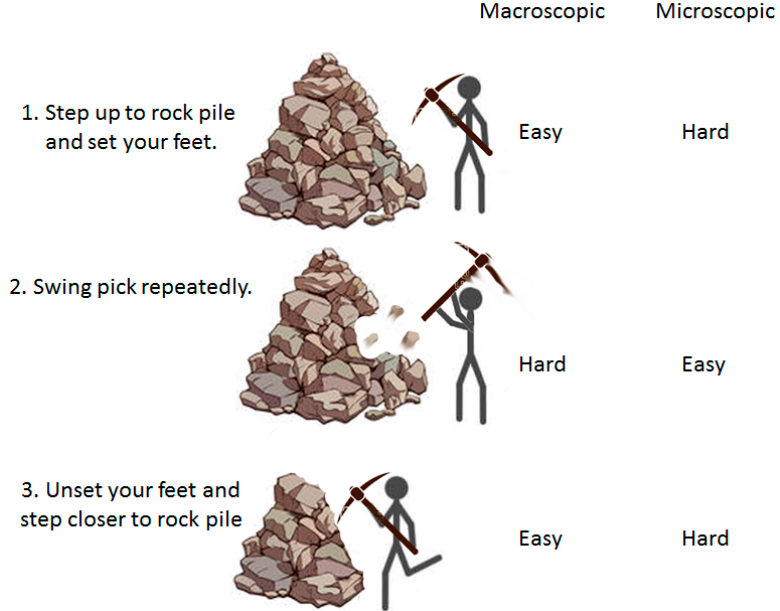
Figure 6. Different steps in breaking up an aggregate are differentially difficult at the macroscopic and microscopic levels. At the macroscopic level stepping up to the aggregate and setting one’s